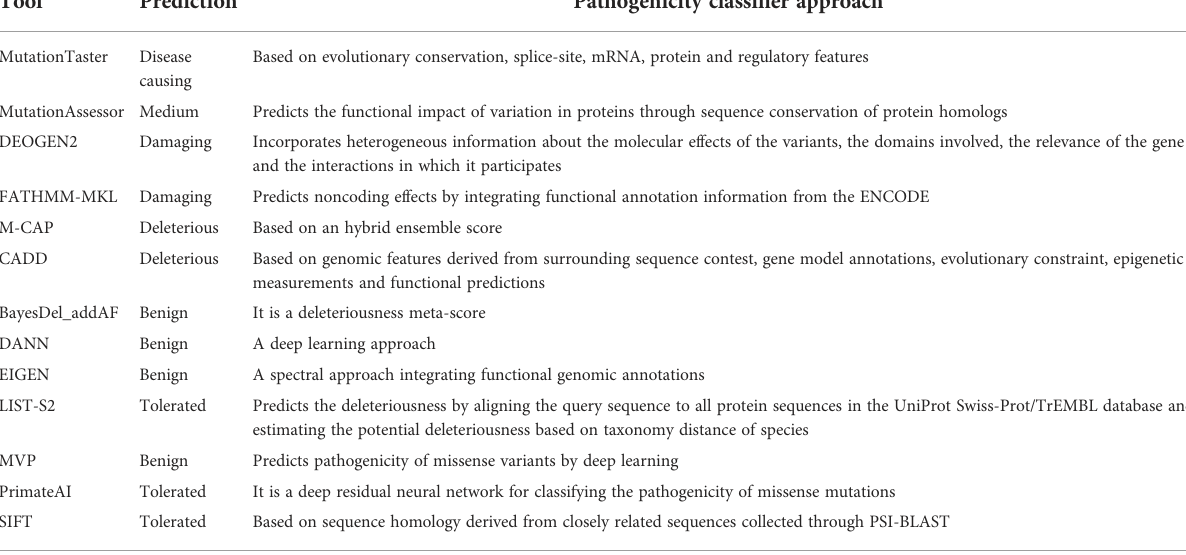
TABLE 2 Effect of the WNT1 p.Leu370Val variant using several in silico